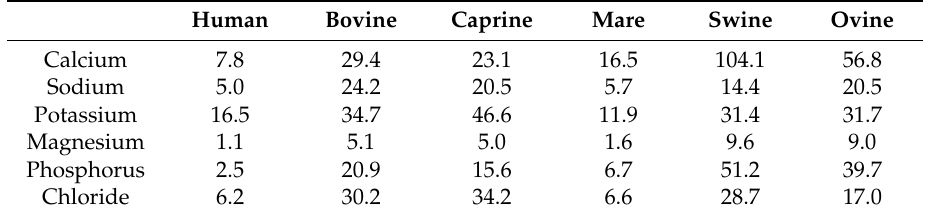
Table 1. Concentration of inorganic elements (mM) in the milk of different species (adapted from [8]). Human Bovine